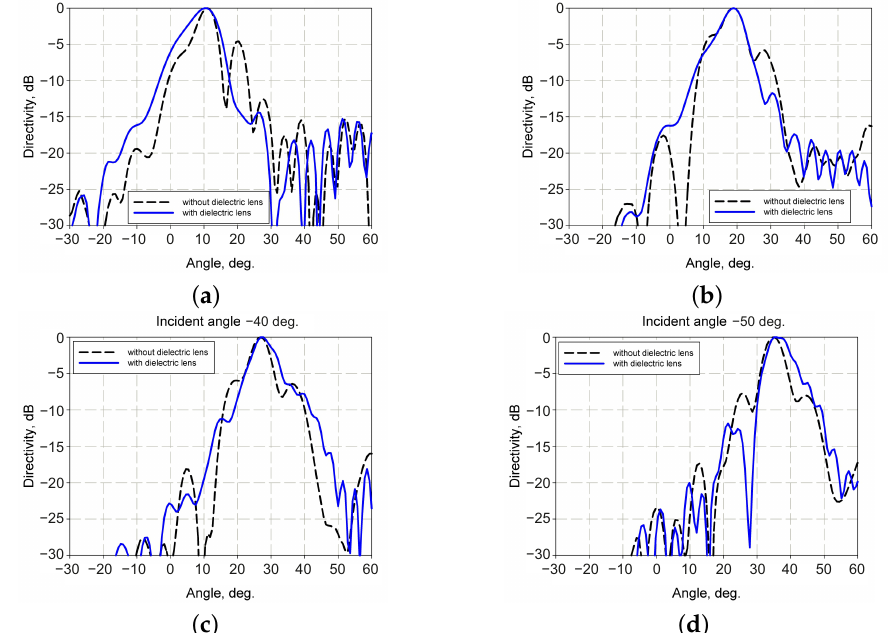
Figure 8. Simulated radiation patterns for primary horn with and without dielectric lens at different incident angles form ( a )